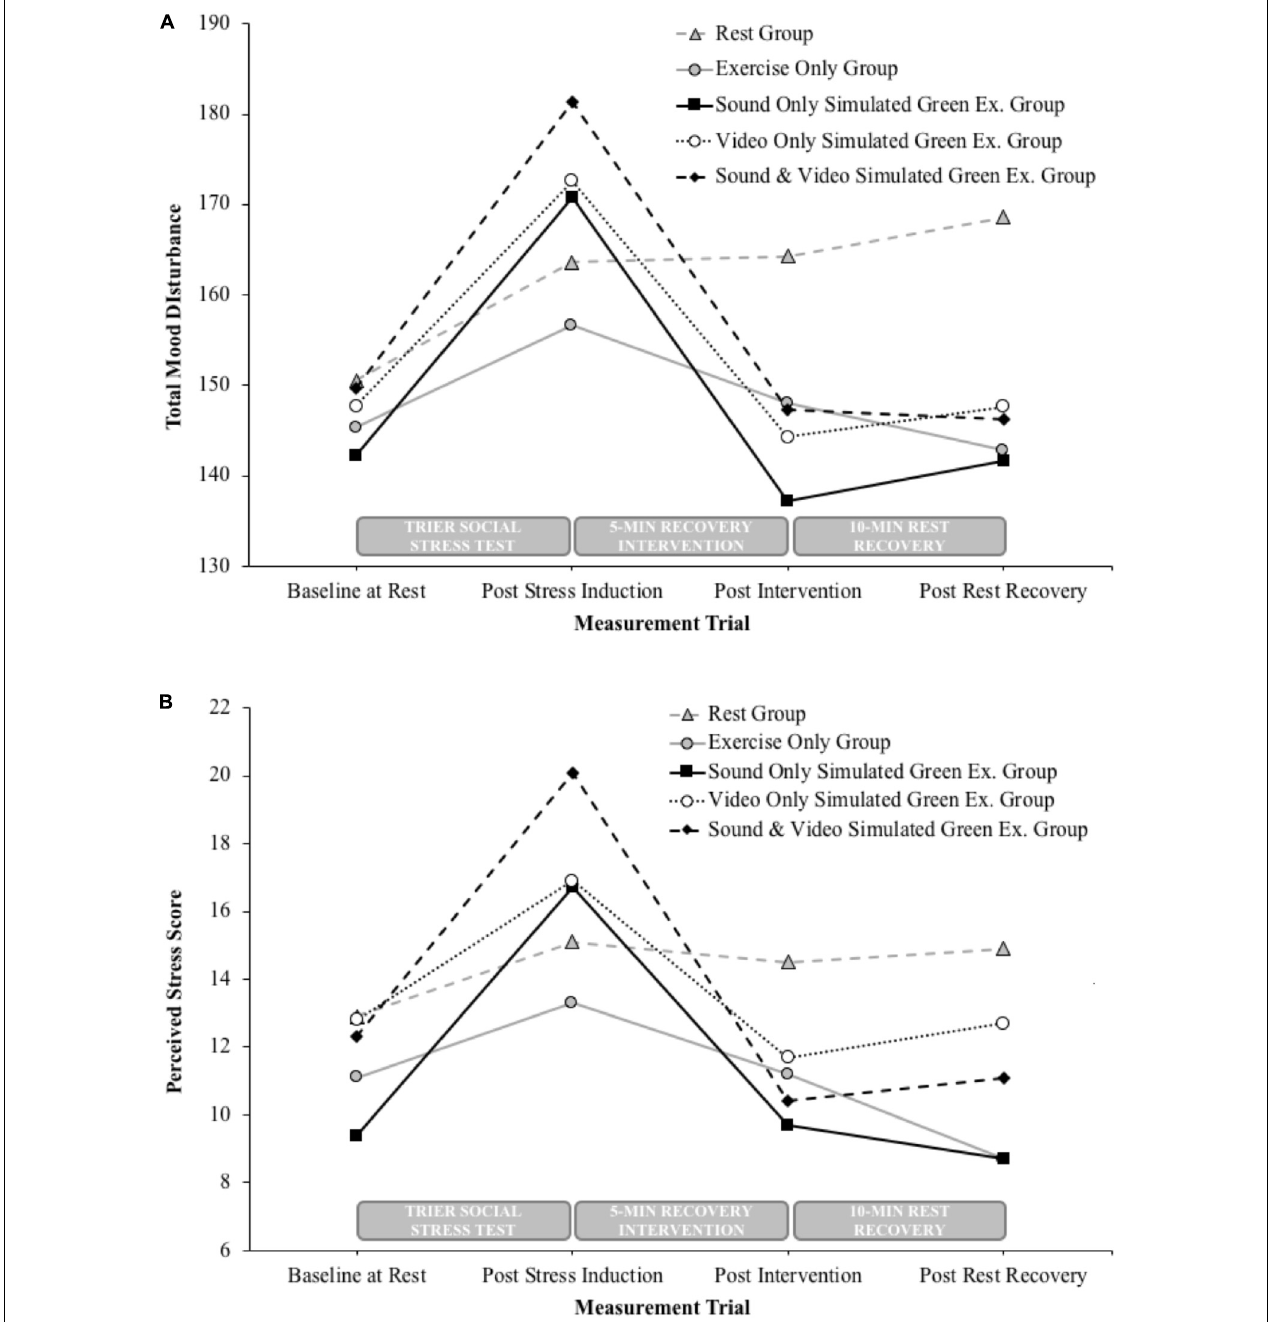
FIGURE 1 | Between group changes in total mood disturbance (A) and perceived stress (B) following the stress induction task, 5-min recovery intervention and 10-min resting